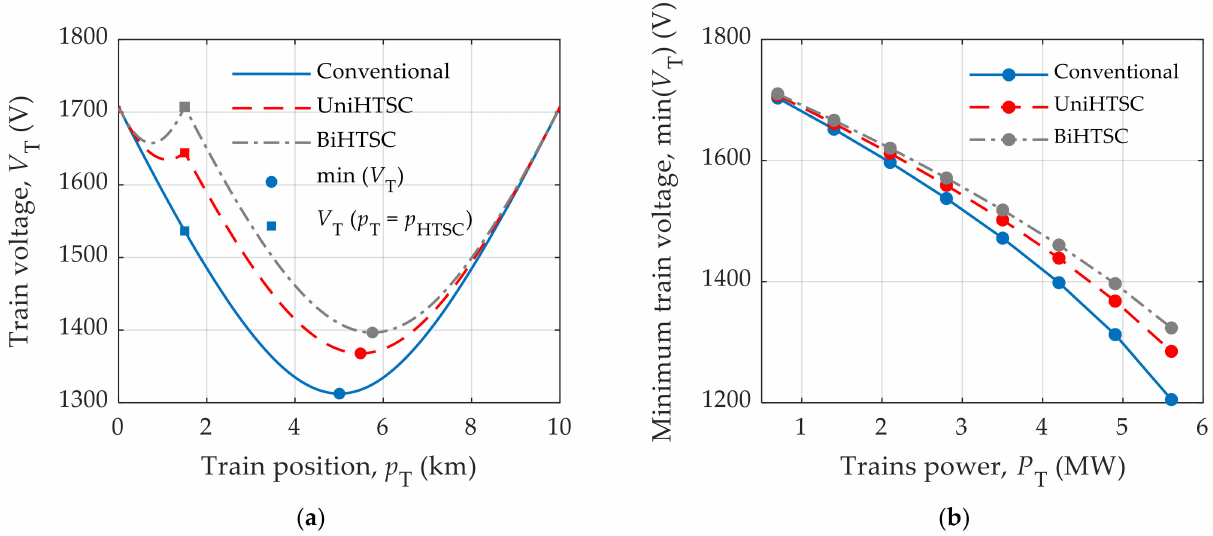
Figure 14. ( a ) Train voltage as a function of its position for a power of 4.9 MW and a cable length of 1.5 km. ( b ) Minimum voltage of the train as a function of the electrical power of the trains for a cable length of 1.5